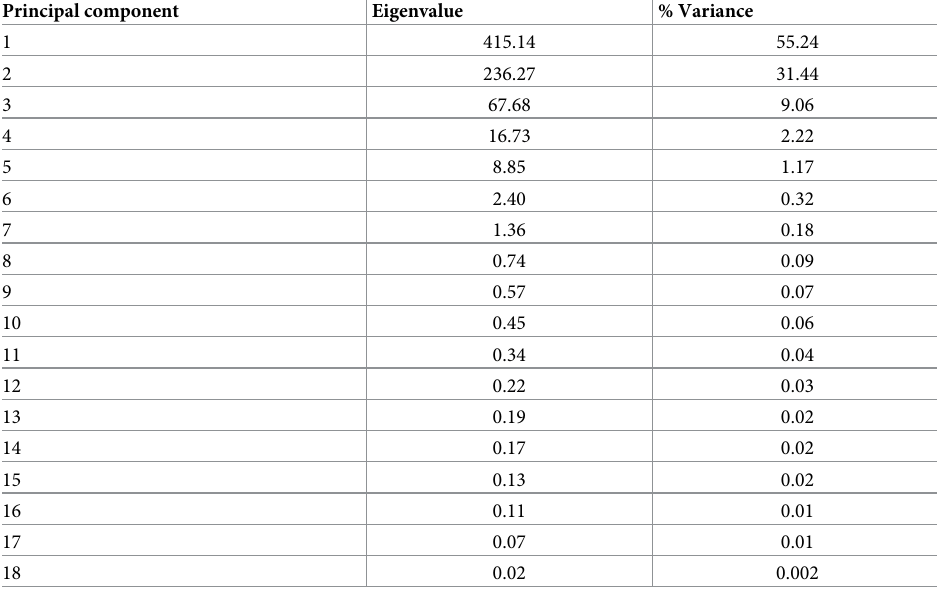
Table 6. Principal components with its eigenvalues and percentage variances towards the total population vari- ance in PCA using quantitative and qualitative traits. Principal component Eigenvalue % Variance